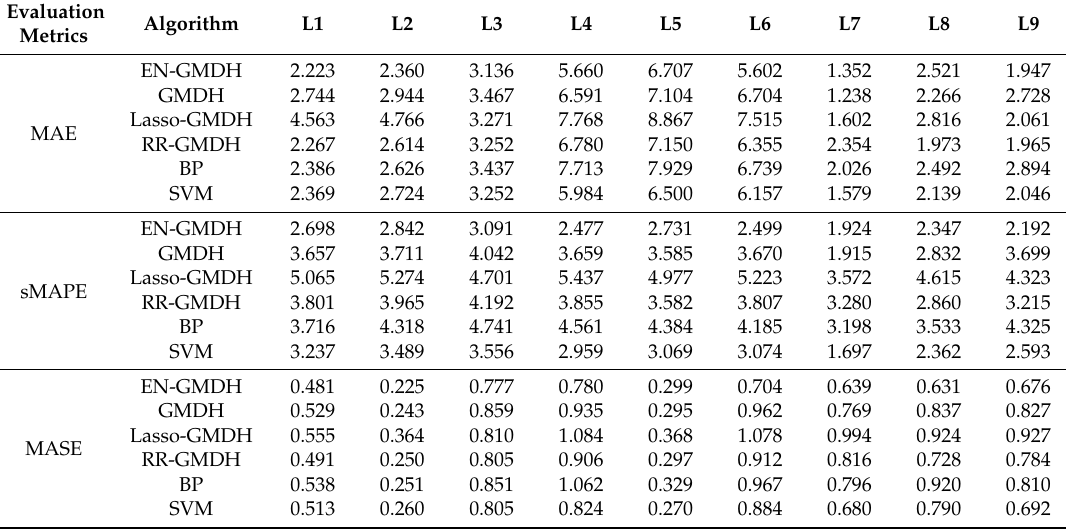
Figure 11. Results of Mean Absolute Scaled Error (MASE) in L1 to L9. Table 5. Evaluation Results. EN-GMDH: group method of data handling based on elastic net; RR: ridge regression; BP: back propagation; SVM: support vector machine; MAE: Mean Absolute Error; sMAPE: Symmetric Mean Absolute Percentage Err; MASE: Mean Absolute Scaled